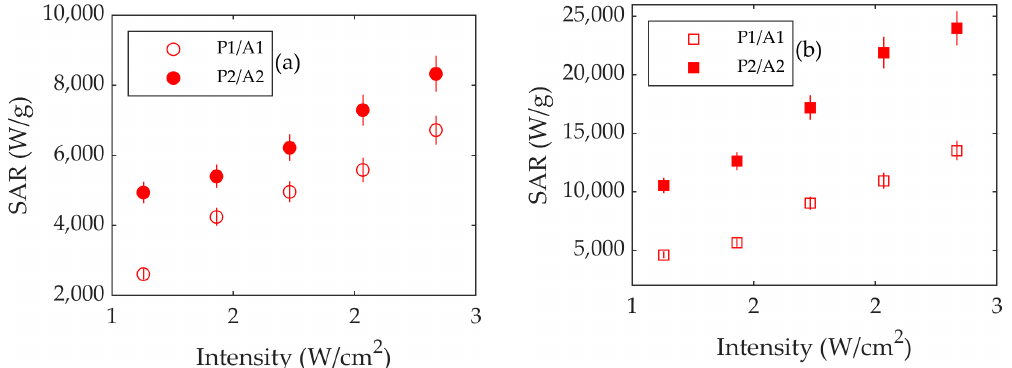
Figure 8. SAR vs. intensity for IRA 980B using lasers at ( a ) 800 nm and ( b ) 1053 nm. Open dots and squares stand for laser diameter S 1 (1300 μ m), and full dots and squares stand for S 2 (1900 μ m). A 1 and A 2 are the laser spot areas corresponding to S 1 and S 2. Errors are represented as vertical bars.